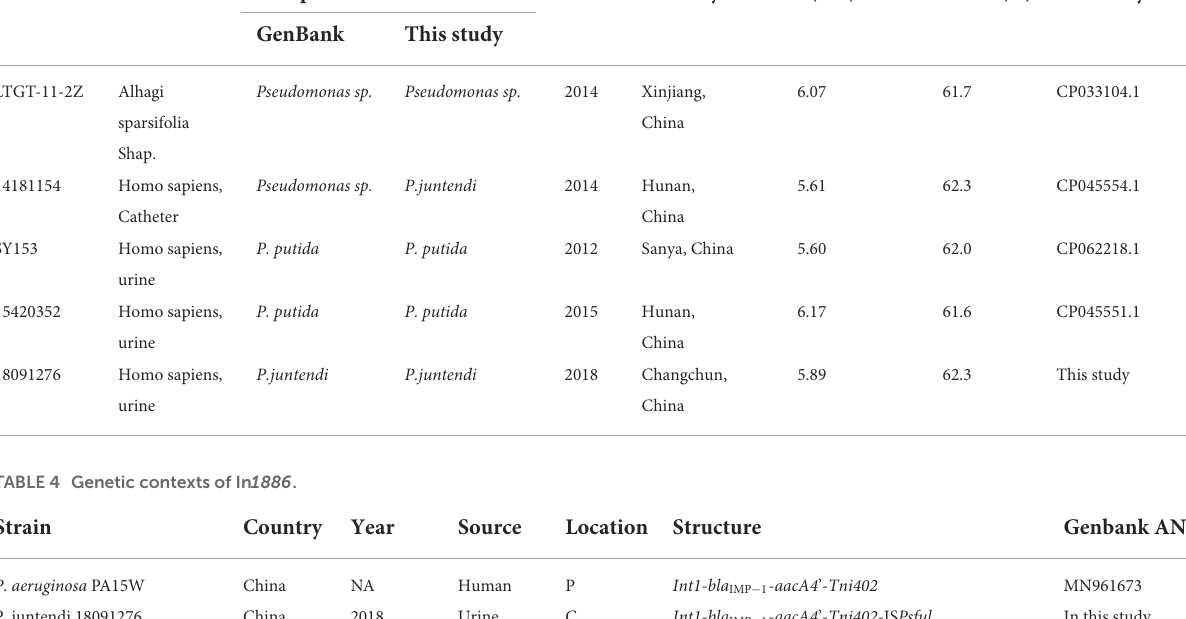
TABLE 3 The information of strains carrying ICEs. Strain